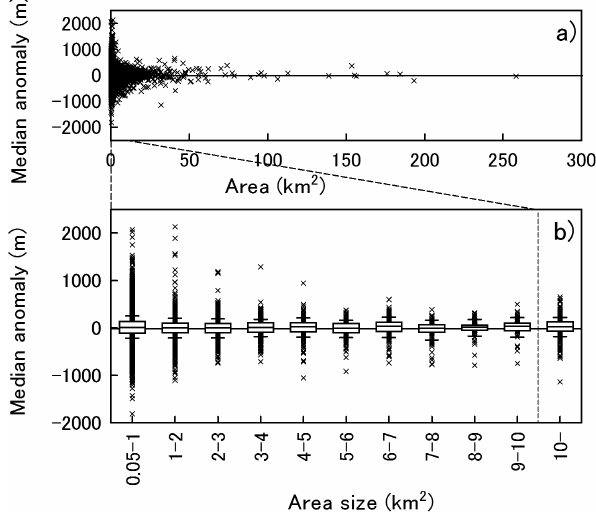
Figure 3. (a) Relation between glacier area and median anomaly, which has glaciers with more than 300 glaciers in the vicinity (within 0.5 ◦ × 0.5 ◦ grid). (b) Median anomaly distribution in 1km 2 bins up to 10km 2 . Boxes give lower and upper quartiles of median glacier altitude in 1km 2 bin. Vertical error bars indicate standard deviation of data range. Crosses lie outside of this